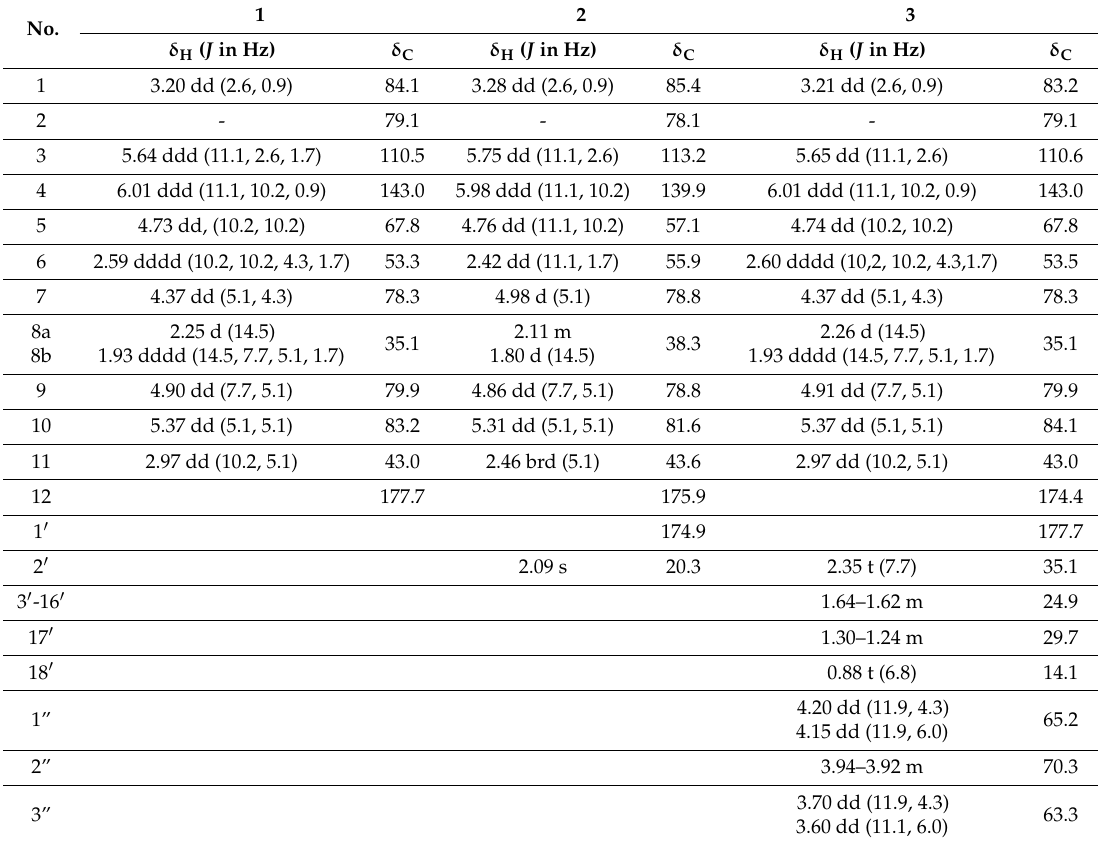
Table 1. 1 H and 13 C NMR spectral data for compounds 1 – 3 a–c